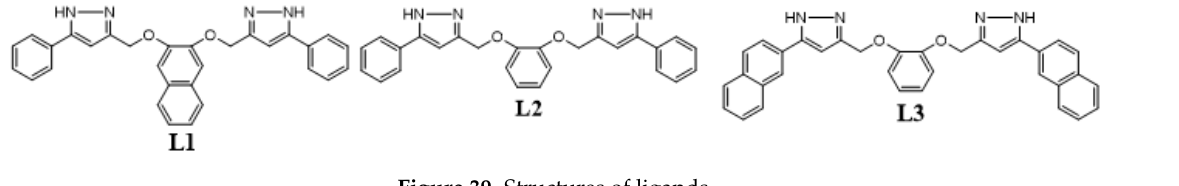
Figure 39. Structures of ligands.